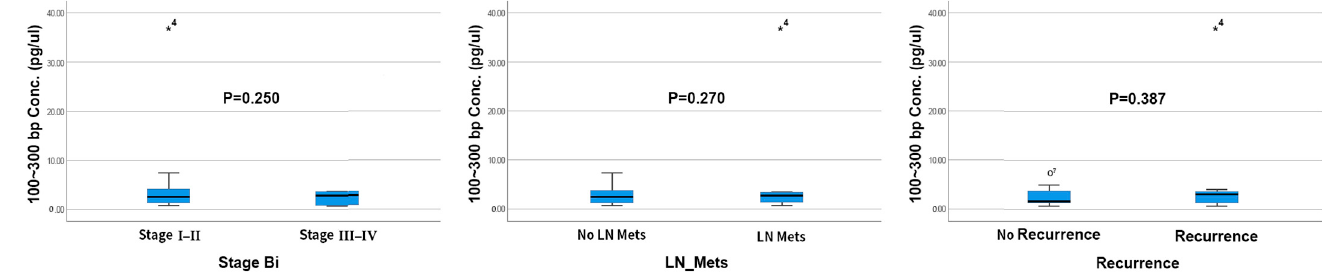
Figure 2. The preoperative plasma cfDNA levels with clinical factors. Mets, metastasis. The case number “*4” showed an extraordinary high concentration level.